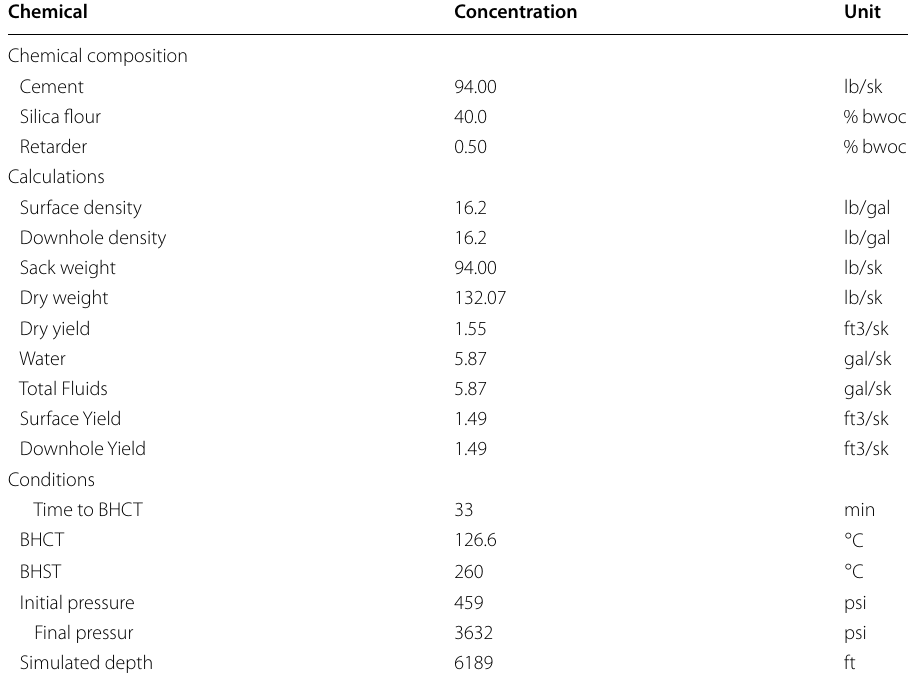
See Table 6 for unit conversion